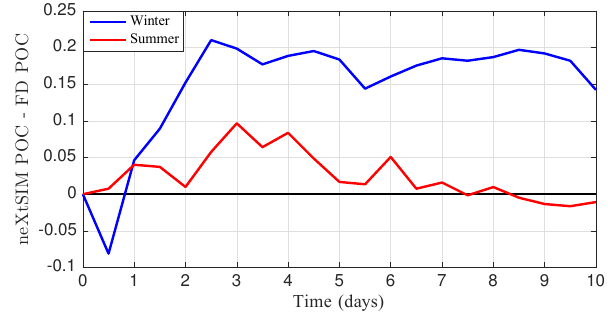
Figure 20. Time evolution of the POC difference between neXtSIM and FD for a search area equal to 50km 2 in winter (blue) and equal to 175km 2 in summer